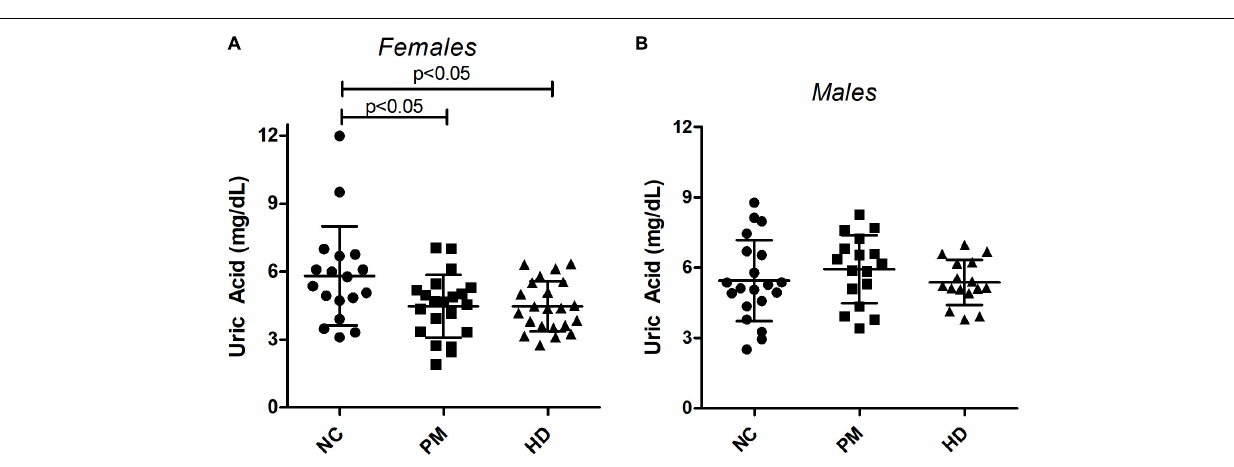
FIGURE 2 | Changes in plasma uric acid (UA) levels by gender and diagnostic group. UA levels were measured in premanifest [pre-Huntington’s disease (PM), manifest HD and normal control (NC) subjects in females (A) and males (B) . Significant differences among diagnostic groups were determined using one-way ANOVA, followed by Bonferroni posttest to compare all groups; p < 0.05. Bars reflect the mean uric acid levels ±